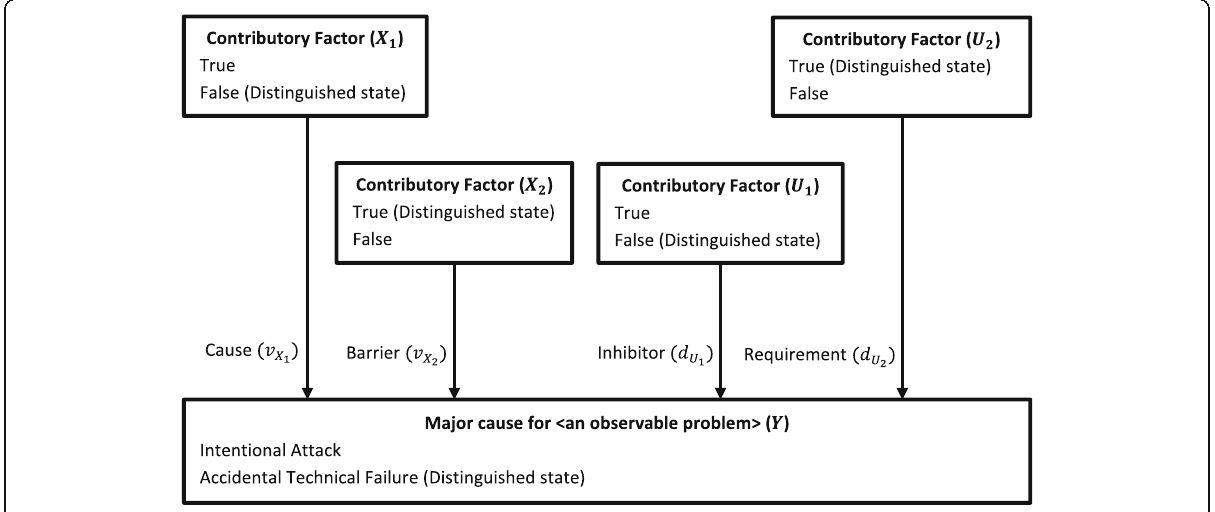
Fig. 3 DeMorgan Model: Causal Interaction